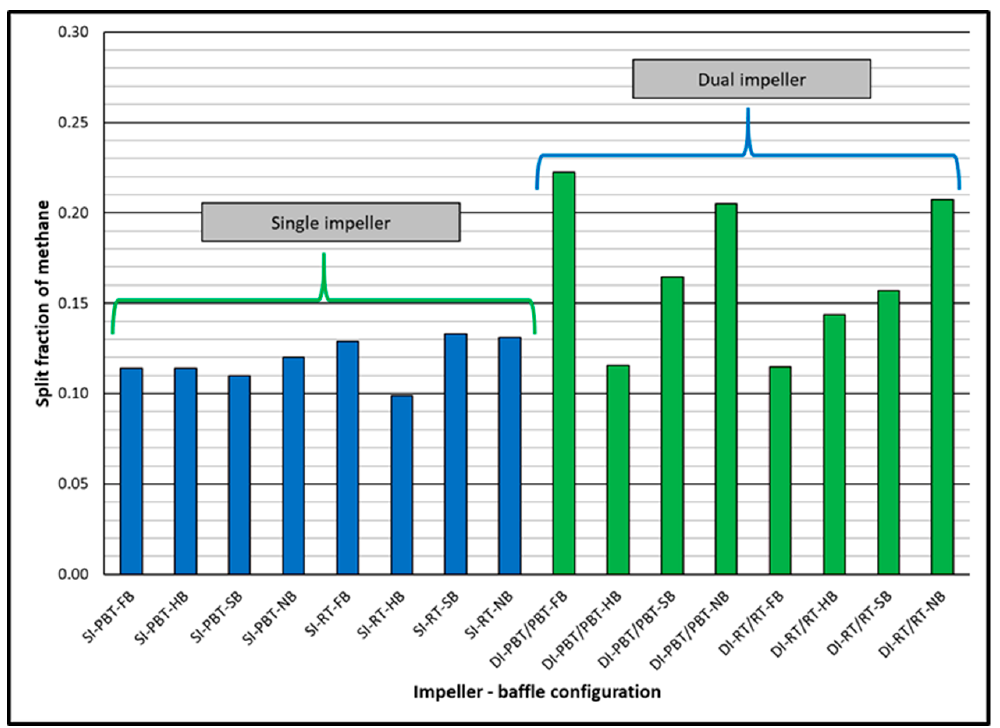
Figure 6. Split fraction of methane for single and dual impeller experiments (experimental temperature 2 °C).